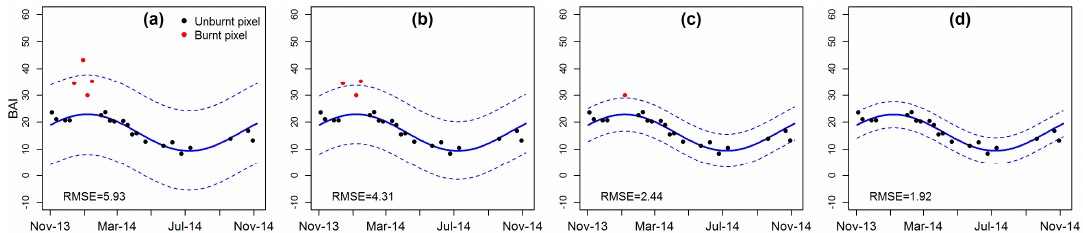
Figure 2. An example of burnt area detection and removal for a grassland savanna field plot. The time series model was fit to the burn area index (BAI) values: ( a ) all pixels; ( b ) one burnt pixel removed; ( c ) three burnt pixels removed; and ( d ) four burnt pixels removed.